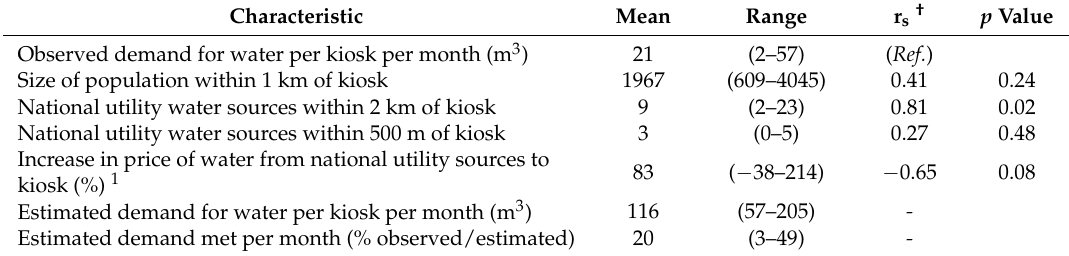
Table 1. Community Characteristics in the Vicinities of Nine Health Care Facilities in Rural Rwanda 2011–2012, Demand for Treated Water from Kiosks Located at the Health Care Facilities, 2013–2014, and Measures of